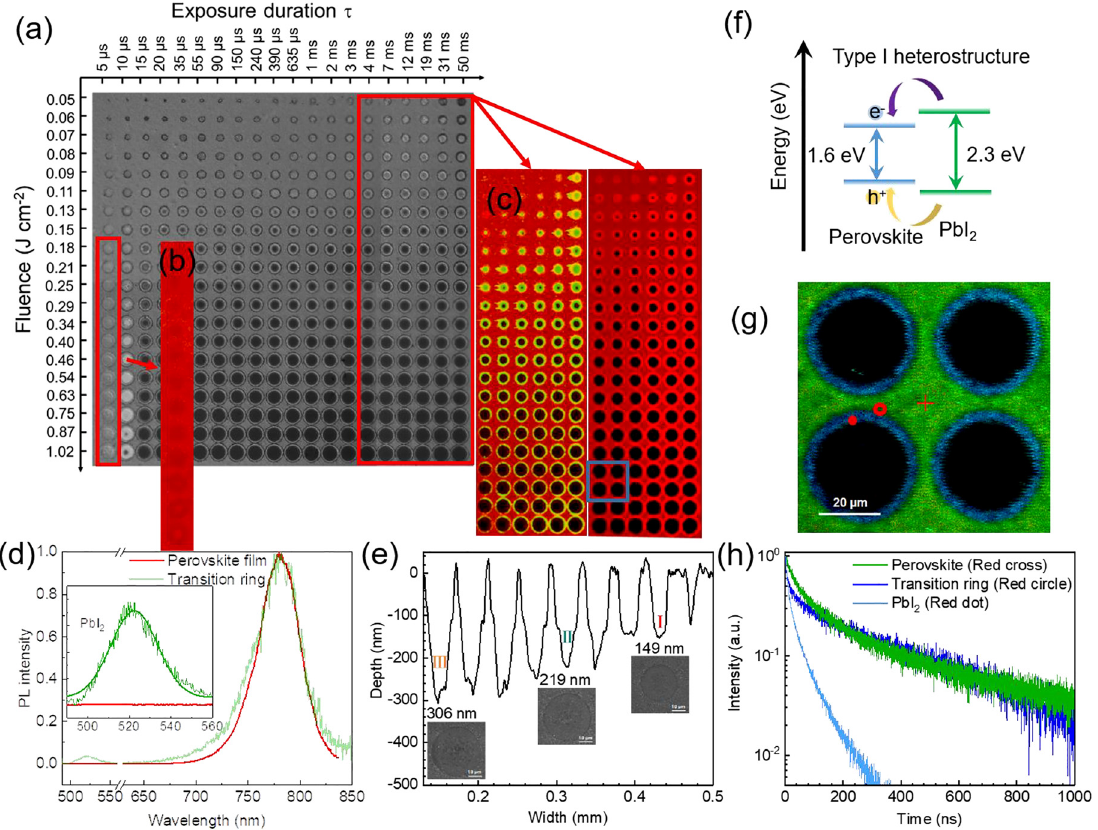
Figure 3: PL and lifetime properties of perovskite films with circular-shaped microholes array. (a) Optical micrograph of perovskite film with circular-shaped micro craters. (b) and (c) Confocal fl uorescent images of the typical areas. (d) Photoluminescence (PL) spectra of perovskite fi lms and HAZ, respectively. (e) Stylus pro fi ler image of perovskite fi lm with circular-shaped microcraters.(f)Schematicofthetype-Iheterostructureforthestudyofthecarrierboundarytransportation.Bothelectronsandholestransfer from PbI 2 to perovskite. (g) Time-resolved PL (TRPL) mapping of perovskite fi lms. (h) TRPL spectra of selected